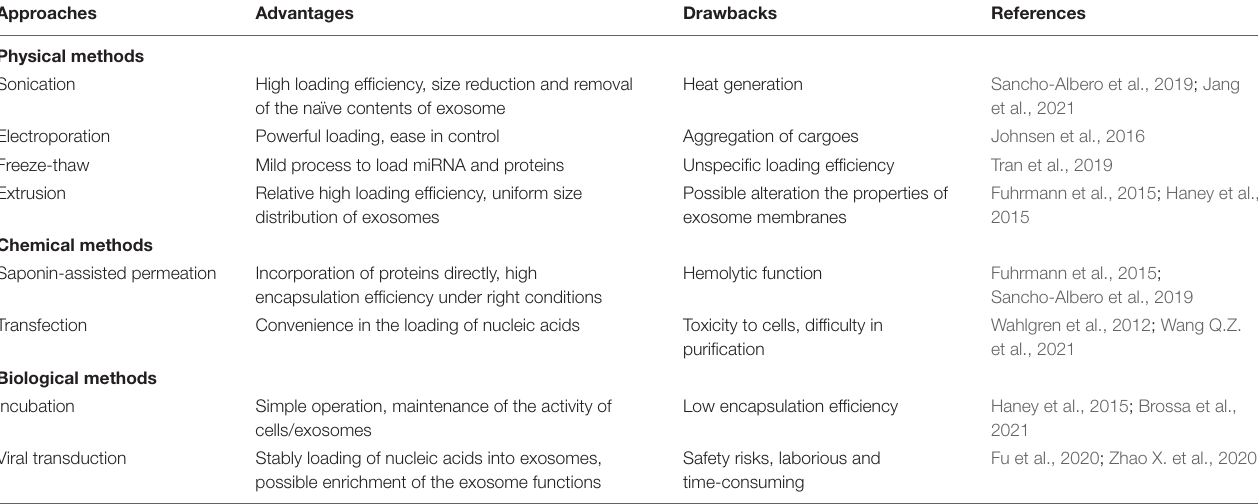
TABLE 1 | Common approaches for cargo loading into